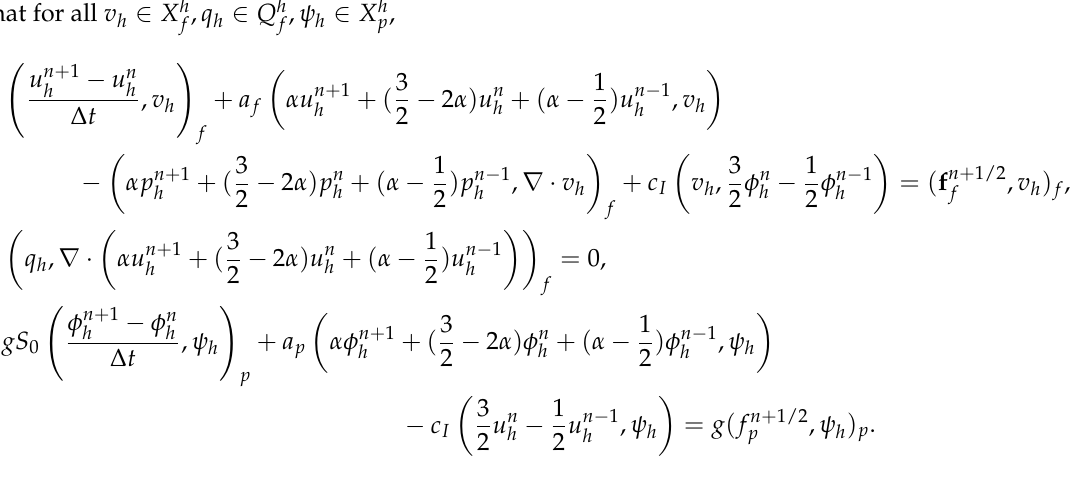
Algorithm 9 Second-order Adam–Moulton–Bashforth method (AMB2)